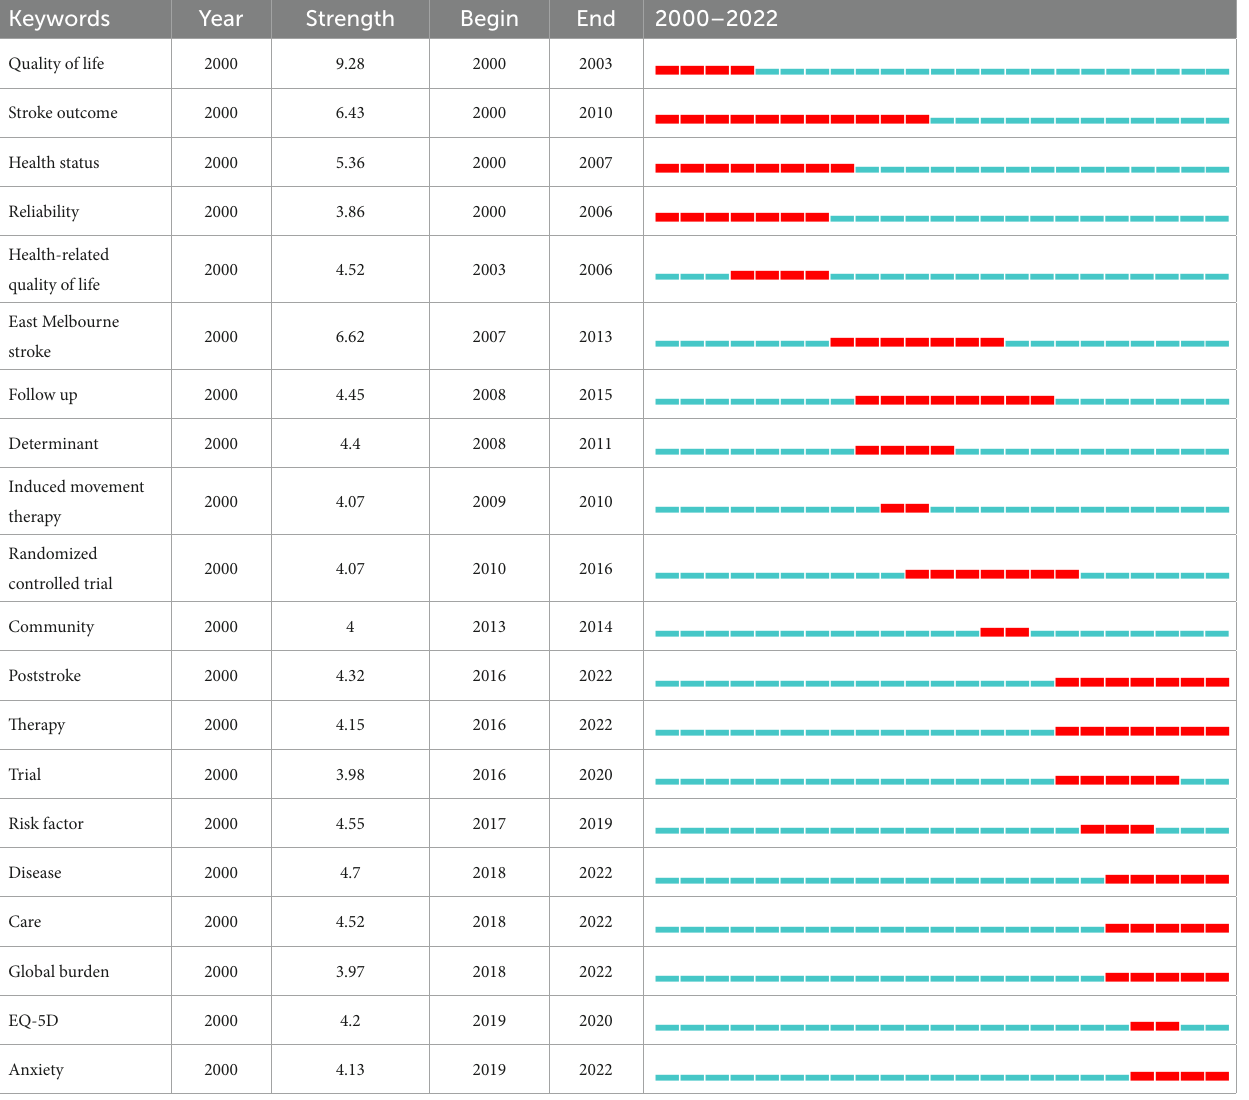
TABLE 10 Top 20 keywords with the strongest citation bursts.